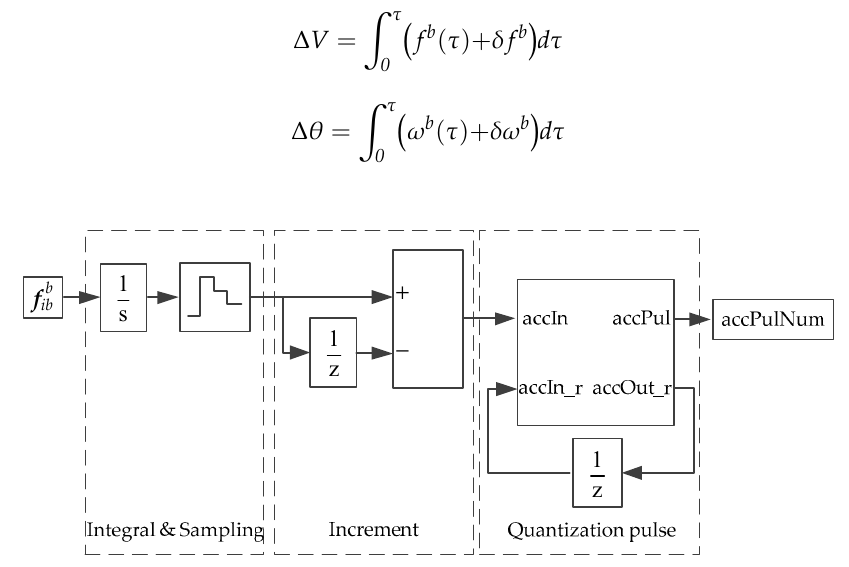
Figure 4. Implementation of velocity increment.